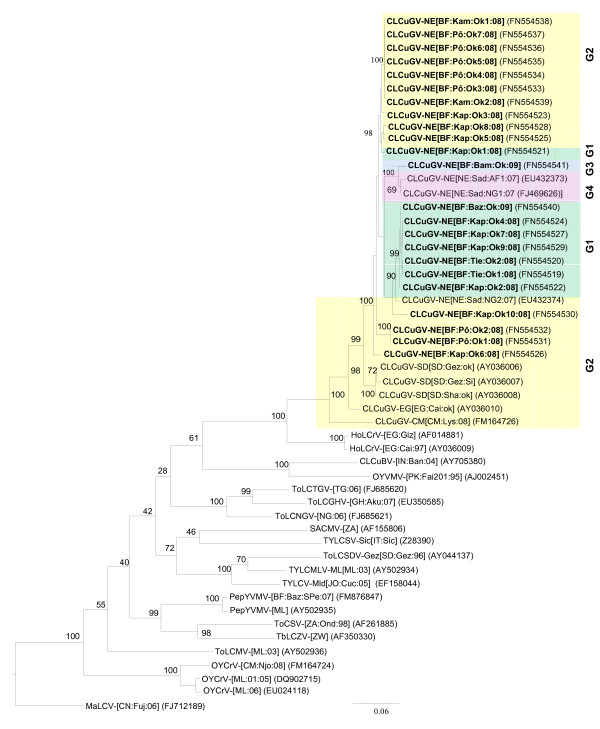
Maximum likelihood tree based on the complete DNA-A sequences of twenty-three Cotton leaf curl Gezira virus isolates from Burkina Faso (in bold; see Table 2 for isolates name and acronyms), plus additional sequences from African and Asian monopartite and bipartite begomoviruses. Begomovirus acronyms used are Cotton leaf curl Gezira virus (CLCuGV), Hollyhock leaf crumple virus (HoLCrV), Cotton leaf curl Bangalore virus (CLCuBV), Okra yellow vein mosaic virus (OYVMV), Tomato leaf curl Togo virus (ToLCTGV), Tomato leaf curl Ghana virus (ToLCGHV), Tomato leaf curl Nigeria virus (ToLCNGV), South African cassava mosaic virus (SACMV), Tomato yellow leaf curl Sardinia virus (TYLCSV), Tomato leaf curl Sudan virus (ToLCSDV), Tomato yellow leaf curl Mali virus (TYLCMLV), Tomato yellow leaf curl virus-Mild (TYLCV-Mld), Pepper yellow vein Mali virus (PepYVMV), Tomato curly stunt virus (ToCSV), Tobacco leaf curl Zimbabwe virus (TbLCZV), Tomato leaf curl Mali virus (ToLCMV), Okra yellow crinkle virus (OYCrV) and Malvastrum leaf curl virus (MaLCV). For the complete description of isolate descriptors refer to Fauquet et al. (2008). Four genetic groups (G1 to G4) have been defined on the presence or absence of recombination events (Figure 4), and are represented here.